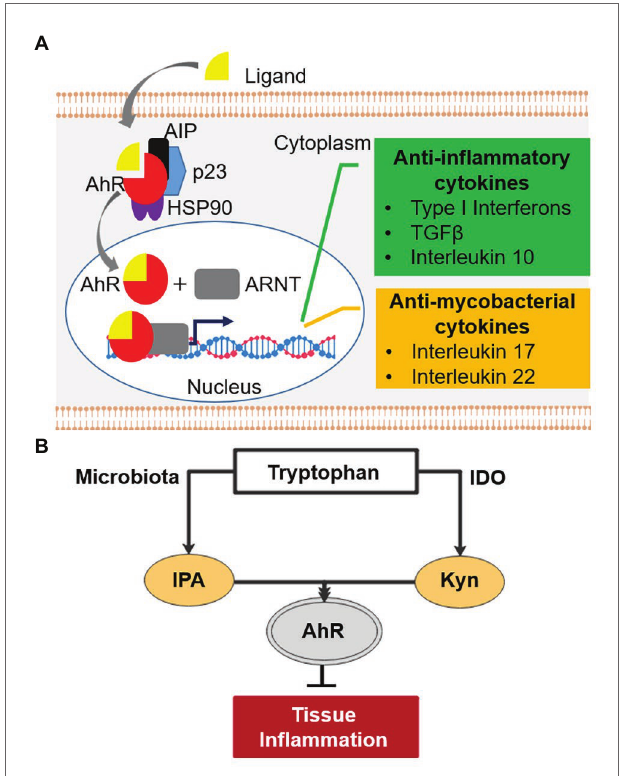
FIGURE 2 | Aryl hydrocarbon receptor (AhR) signaling pathway and tryptophan-indoleamine 2,3-dioxygenase (IDO)-AhR axis. (A) AhR (red) is localized in the cytosol of human cells in complex with other proteins. Upon activation by ligands (e.g., tryptophan metabolites), AhR is released from the complex and binds its partner, the AhR nuclear translocator (ARNT) in the nucleus. The complex of AhR and ARNT binds upstream of target genes and enhances the expression of anti-inflammatory (green) and “antimycobacterial” cytokines (orange). AIP, AhR-interacting protein; p23, chaperone; HSP90, 90 kDa heat shock protein. (B) Tryptophan-IDO-AhR axis in